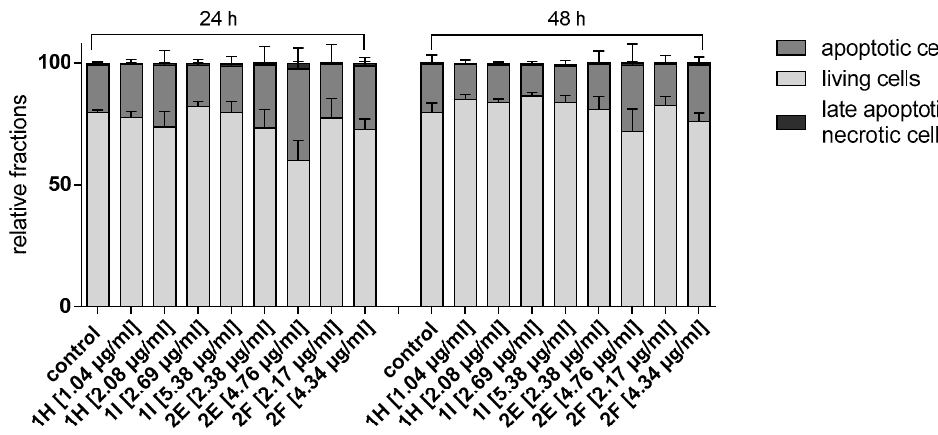
Figure 4. E ff ect of column chromatography fractions 1H, 1I 2E, 2F (at IC 50 concentration and doubled the IC 50 concentration) on induction of apoptosis in SiSo cancer cell line after 24 and 48 h incubation